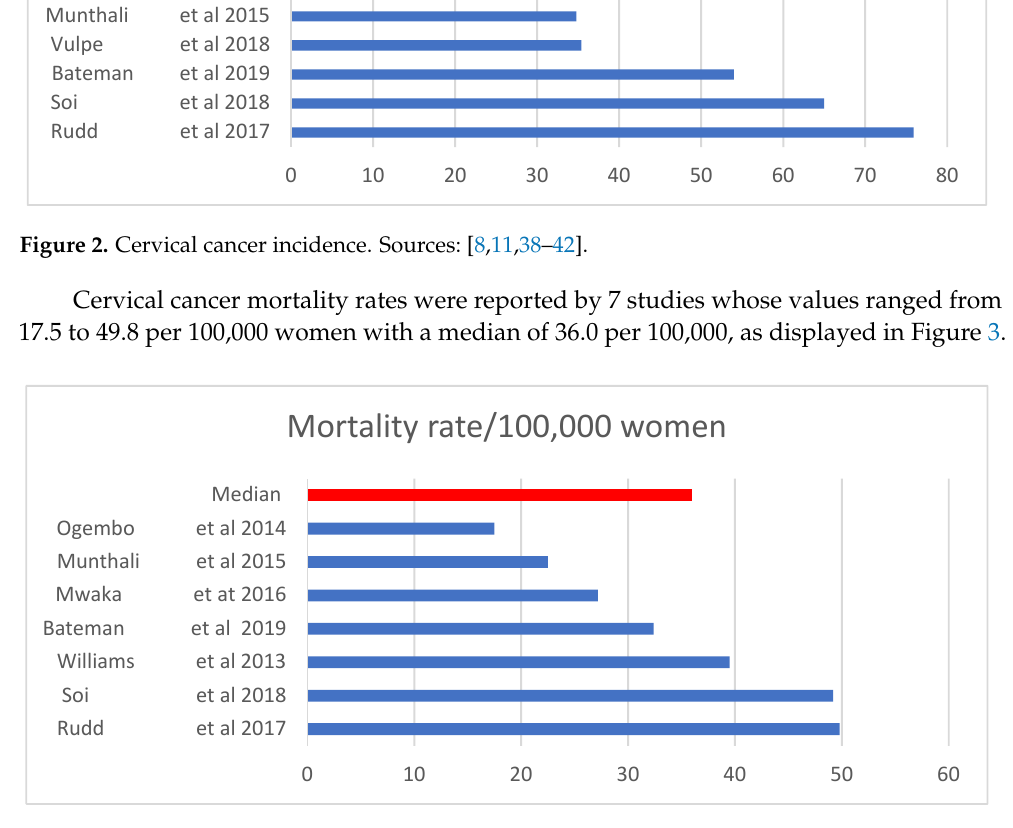
Figure 4. Cervical cancer survival rate. Source: [13,25,40,46]. 3.1. Factors Associated with High HPV Vaccine Coverage Adolescents, guardians, key informants and important stakeholders were among the study population for the 10 articles that were included in the analysis of factors asso- ciated with high HPV vaccine coverage. Among those articles that reported the HPV vaccine coverage levels, the pooled estimate of the HPV vaccine coverage level was es- timated to be 86% and a 95% confidence interval ranging from 81% to 90%, as shown in Figure 5.